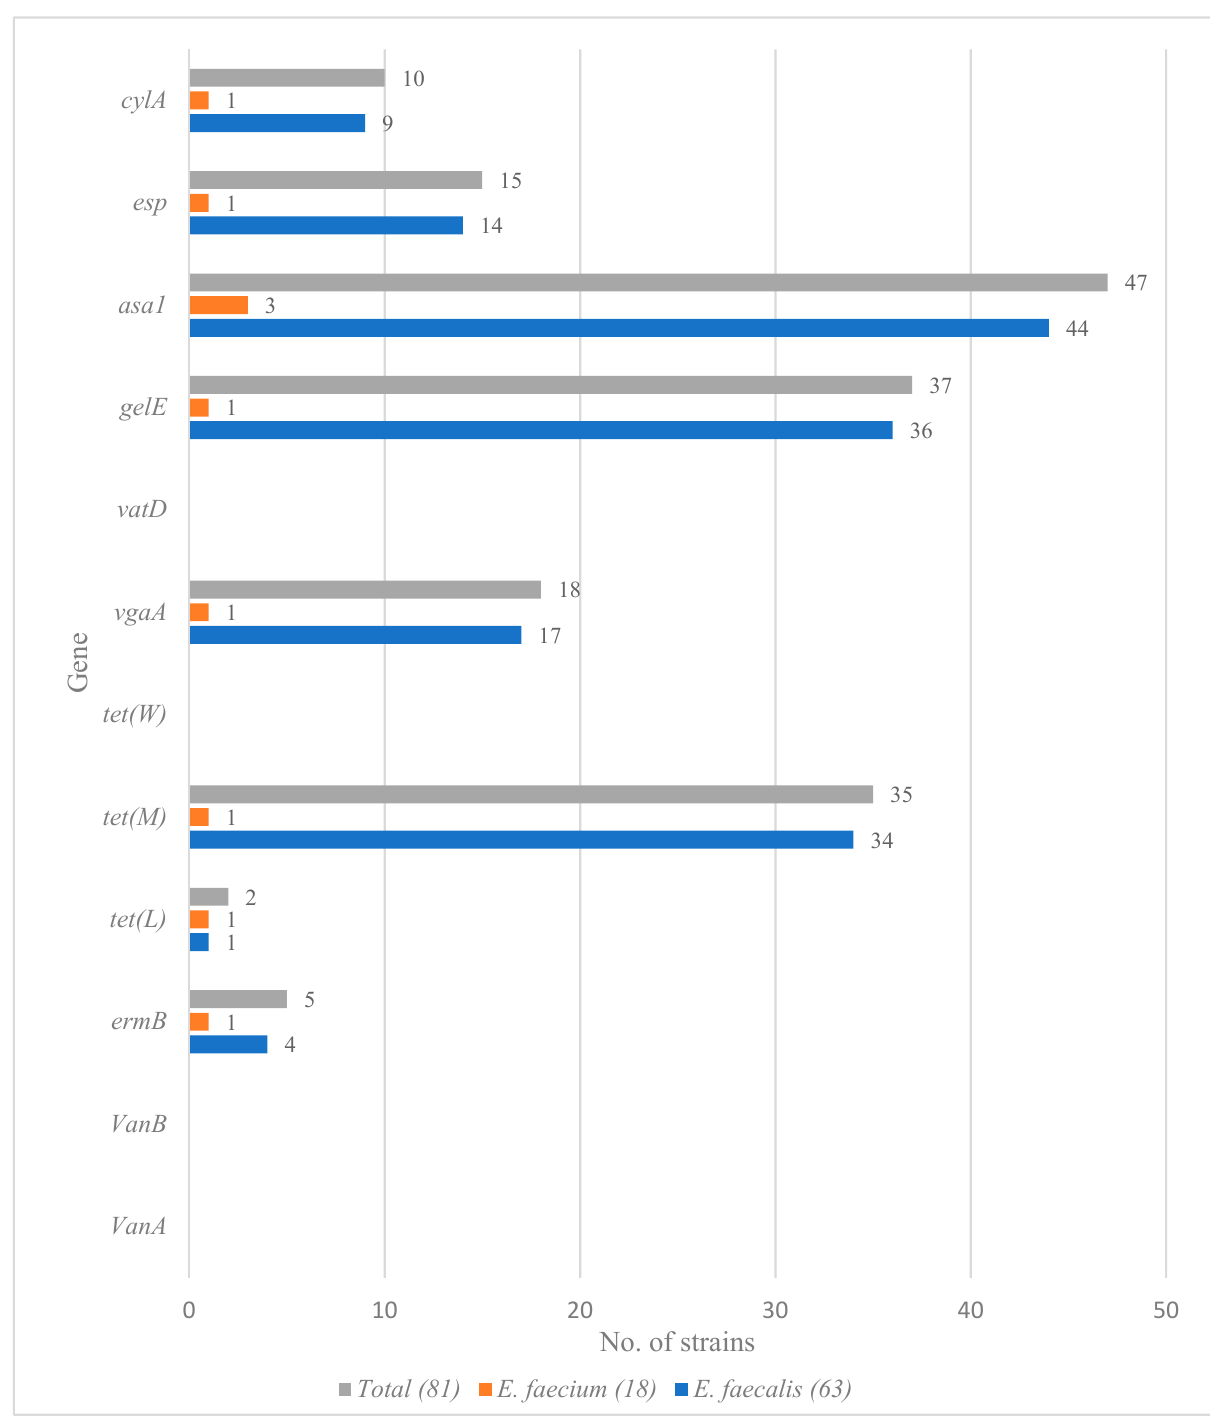
Figure 2. Distribution of virulence and resistance genes among Enterococcus faecium and Enterococcus faecalis . 3.4. Connection between Resistance Genes and Phenotypical Resistance to Antimicrobials Table 3. Multiple virulence genes patterns in Enterococcus faecalis and Enterococcus faecium isolates. The occurrence of resistance genes was compared with phenotypic resistance to an- timicrobial agents (Table 4). Out of 40 tetracycline-resistant E. faecalis isolates, 33 had the tet(M) gene and 1 had the tet(M) and tet(L) genes. Only one tetracycline-resistant strain of E. faecium possessed the tet(M) and tet(L) genes. Erythromycin-resistant E. faecalis strains amount to four (out of the six) possessed the 2- ermB , 1- vgaA, 1- ermB and vgaA